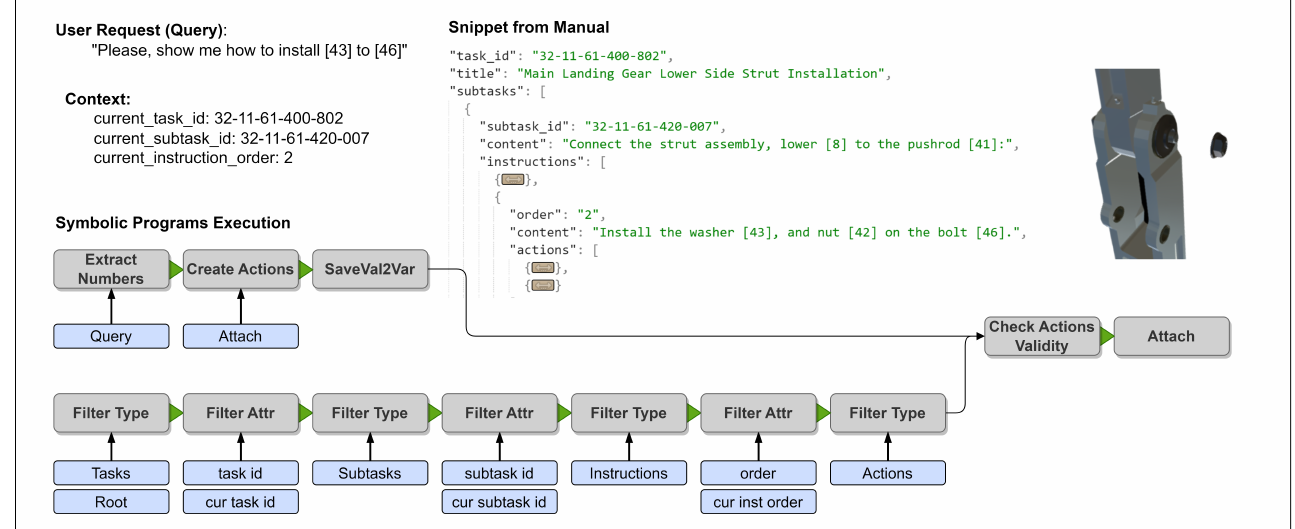
Figure 6. Example of execution of symbolic